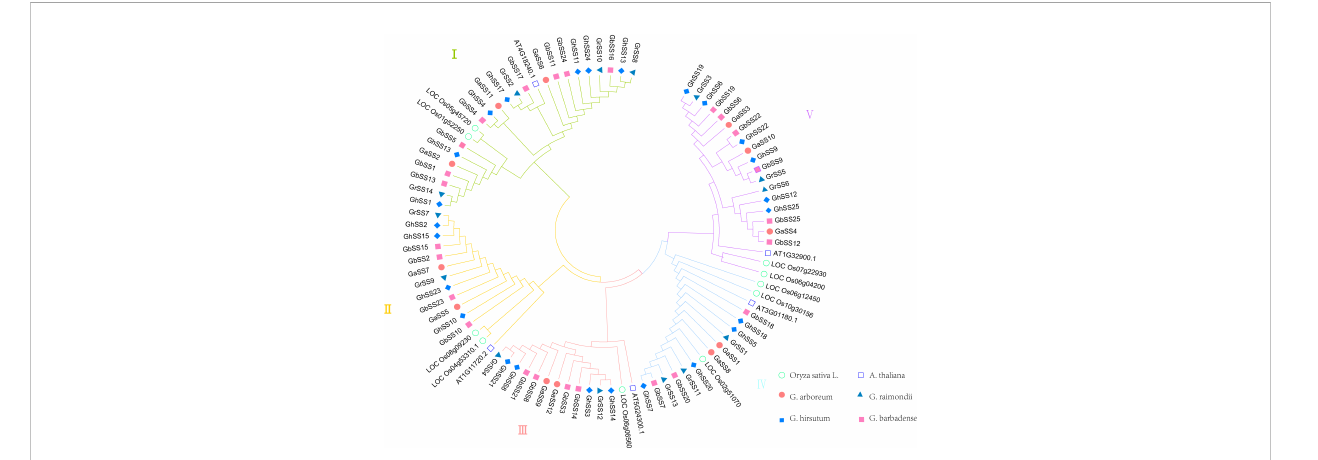
FIGURE 1 Phylogenetic analysis of SS protein from Oryza sativa L., Arabidopsis thaliana , and